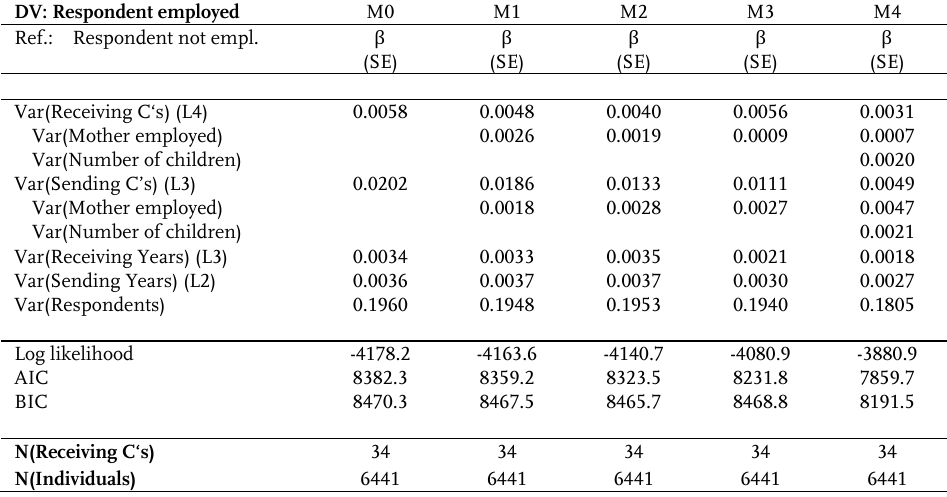
Table A.8 : Linear multilevel probability models for female immigrants’ employment (M1, M2 &